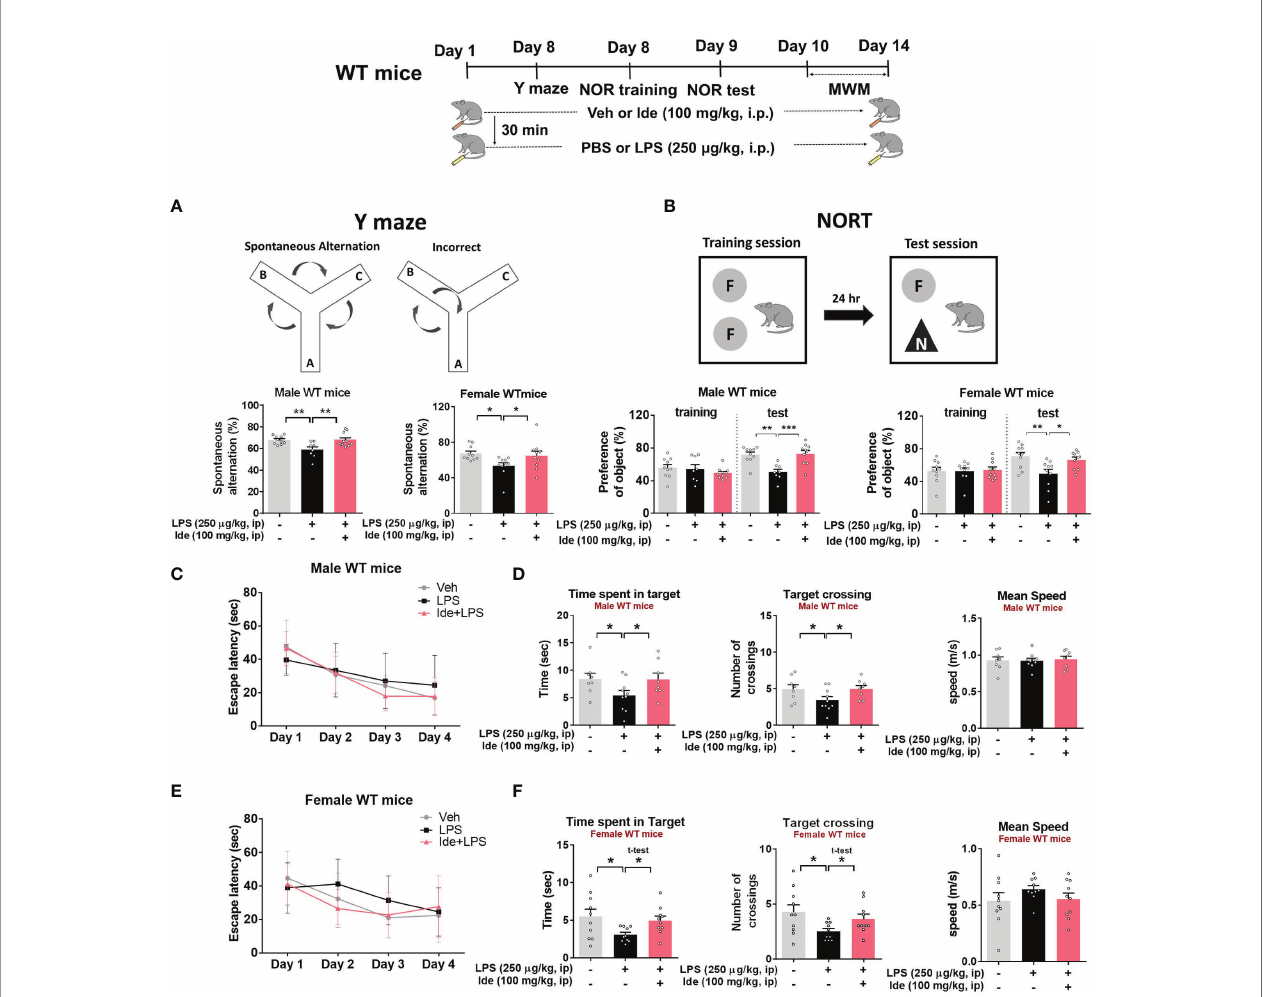
FIGURE 2 | Idebenone attenuates LPS-induced memory impairments in male and female wild-type mice. Male and female wild-type mice were treated as described in Figure 1 , and Y maze, novel object recognition (NOR), and Morris water maze tests were performed on days 8, 9, and 10 – 14, respectively. (A) Y maze diagram and quanti fi cation of spontaneous alternations (n = 8-10/group). (B) NOR test diagram and quanti fi cation of object preference (n = 8-10/group). (C, E) Escape latency to fi nd the hidden platform during the training session of the Morris water maze test (n = 8-10/group). (D, F) Time spent in the target quadrant, number of target crossings, and mean speed in the Morris water maze probe test (n = 8-10/group). *p < 0.05, **p < 0.01 and ***p <